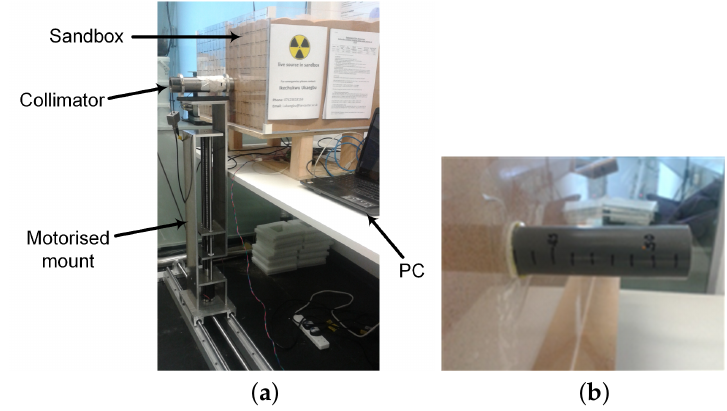
Figure 3. ( a ) Experiment setup; ( b ) graduated pipe for adjusting the distance of the source from the front of the